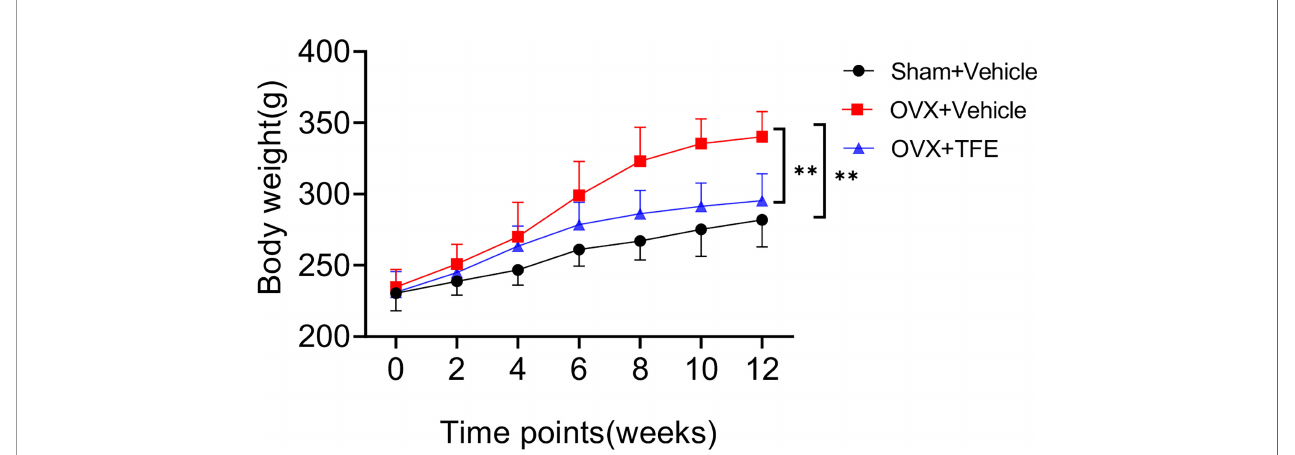
FIGURE 2 | Body weights of rats in all treatment groups throughout the experimental period. Values are presented as mean ± SD (Sham, n = 11; OVX, n = 10; TFE, n = 11). OVX, ovariectomy; Sham, sham-operation; TFE, total fl avonoids of Epimedium. P values represent Bonferroni-corrected p -values (two-way repeated- measures ANOVA). ** P < 0.001 between the OVX and Sham controls and between the OVX controls and TFE-treated group at week